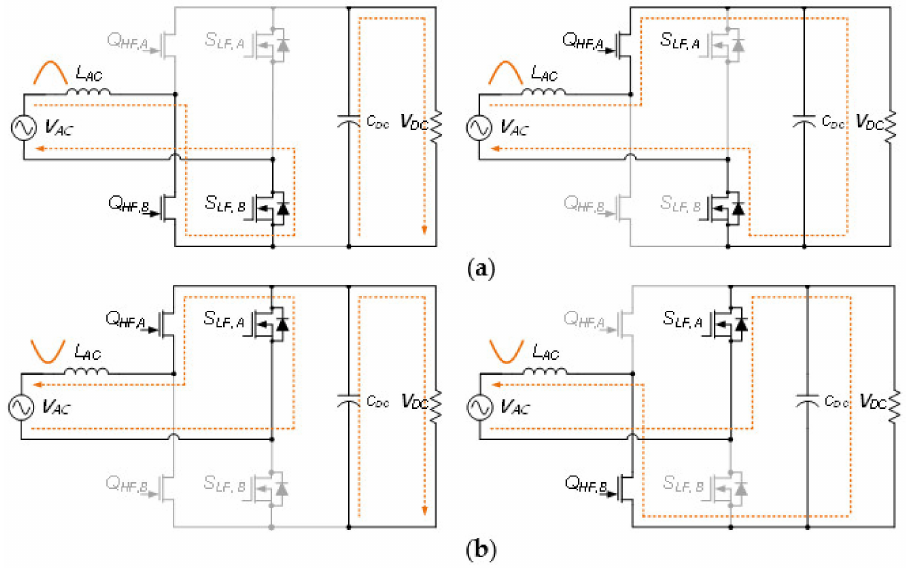
Figure 2. Stages of operation for totem-pole PFC. ( a ) positive half and ( b ) negative